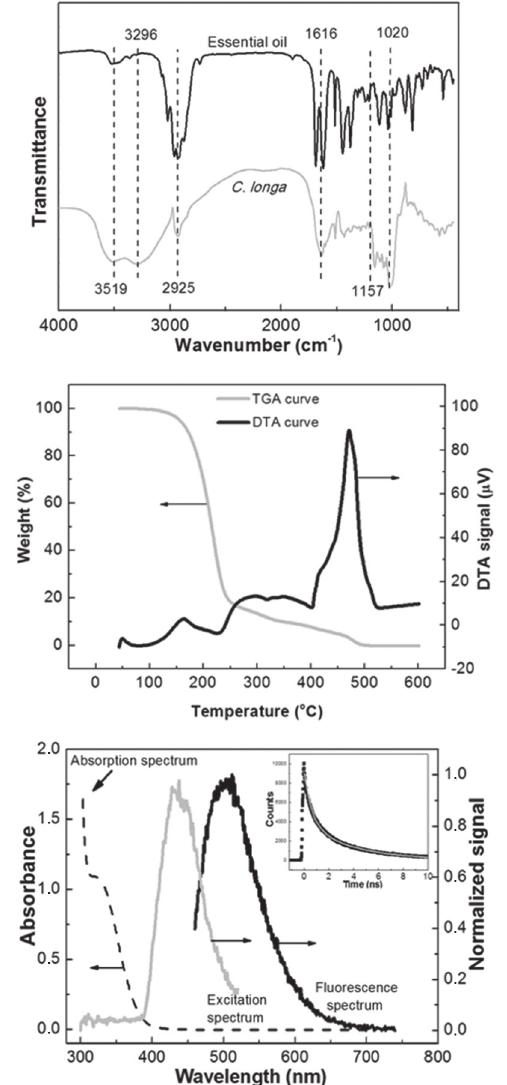
Figure 1 - ( a ) FTIR spectra of C. longa tumeric powder and essential oil extracted from C. longa , ( b ) TGA and dTA curves of essential oil, and ( c ) UV-Vis absorption, normalized emission and normalized excitation spectra. The inset shows the time-resolved fluorescence of essential oil of C. longa